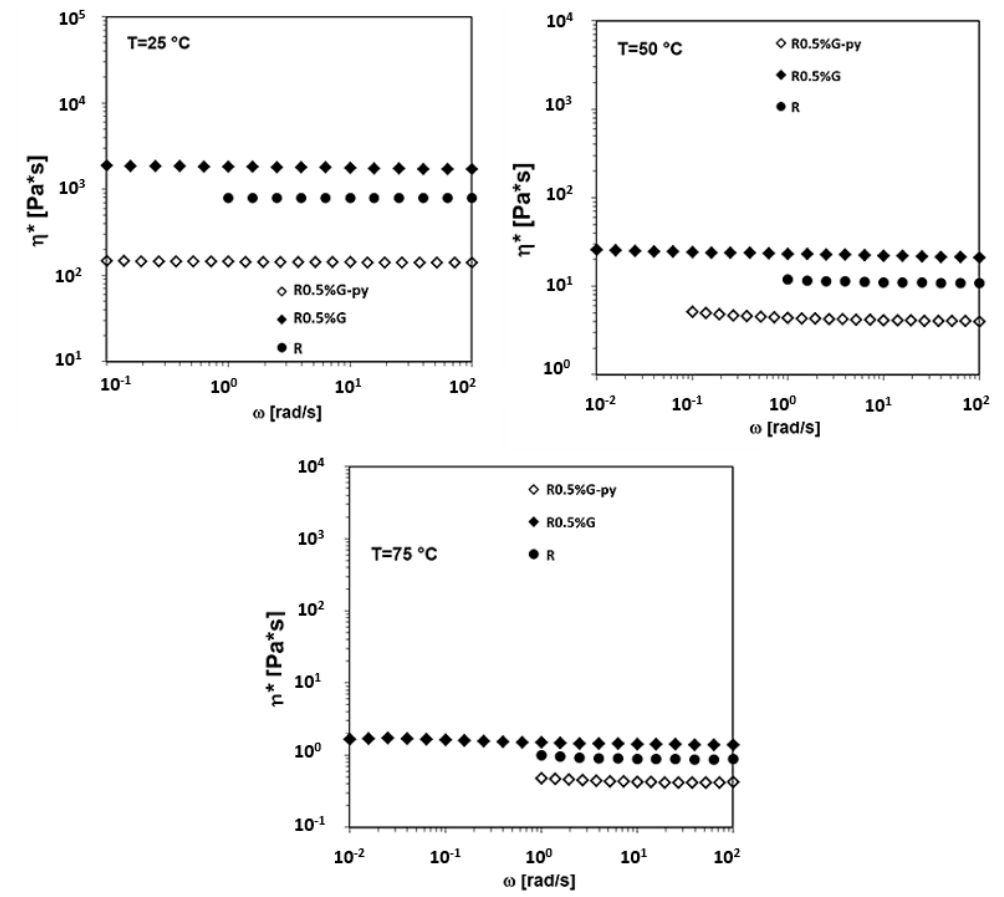
Figure 23. Complex viscosity vs frequency at T = 25 °C, T = 50 °C and T = 75 °C for the R uncured epoxy matrix, the R0.5%G and the R0.5%G-py by wt liquid dispersions.